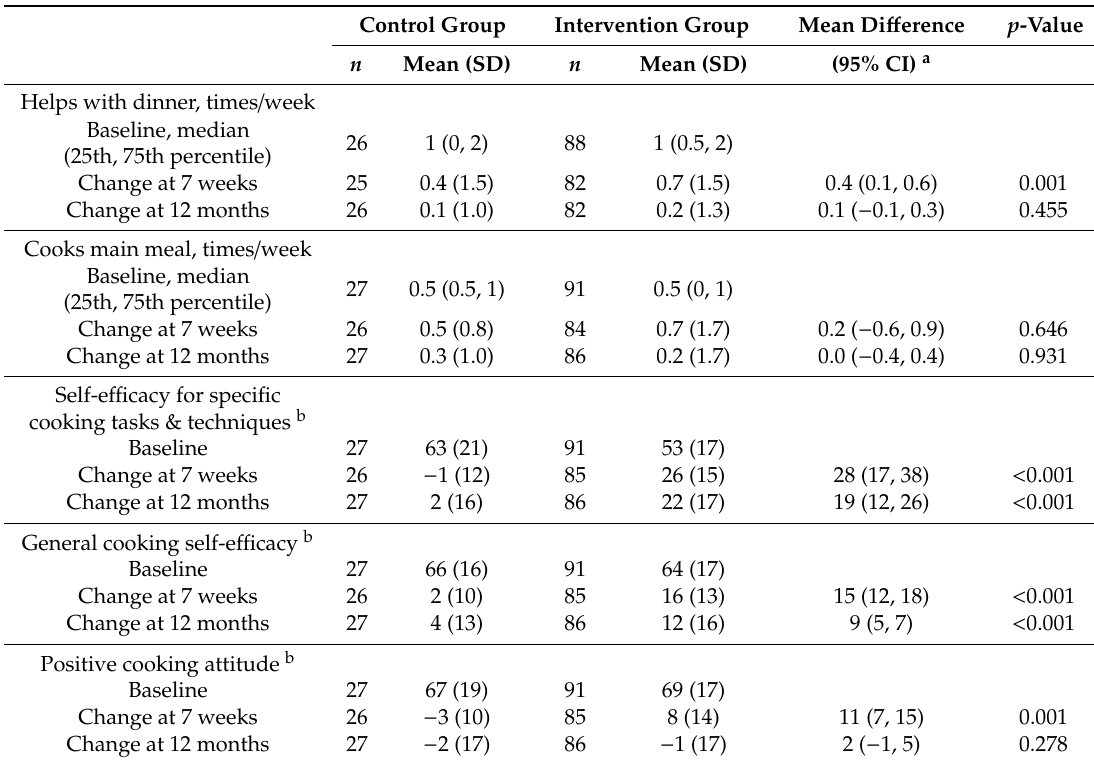
Table 3. E ff ect of the COOK intervention on cooking skills, attitudes, and self-e ffi cacy at 7 weeks and 12 months ( n =